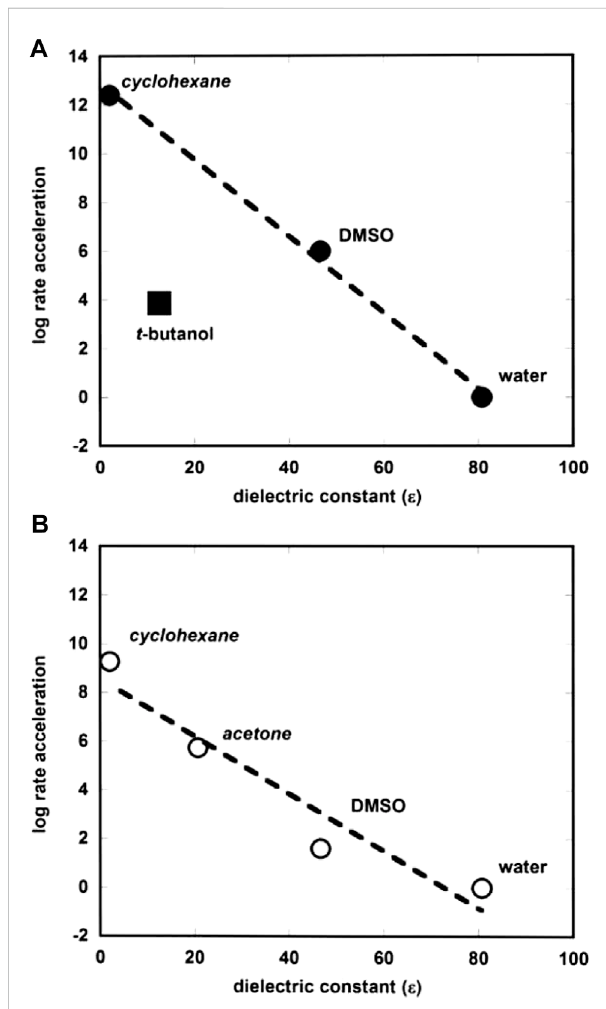
FIGURE 6 Plots of log rate acceleration versus dielectric constant ( ε ) of solvents for the hydrolysis of (A) phosphate monoester dianions and (B) phosphate diesters. Solvents in italics denote reactions involving alkyl phosphate substrates. Reprinted with permission of M. Forconi (2015) Adv. Phys. Org. Chem. 49, 57 – 101.